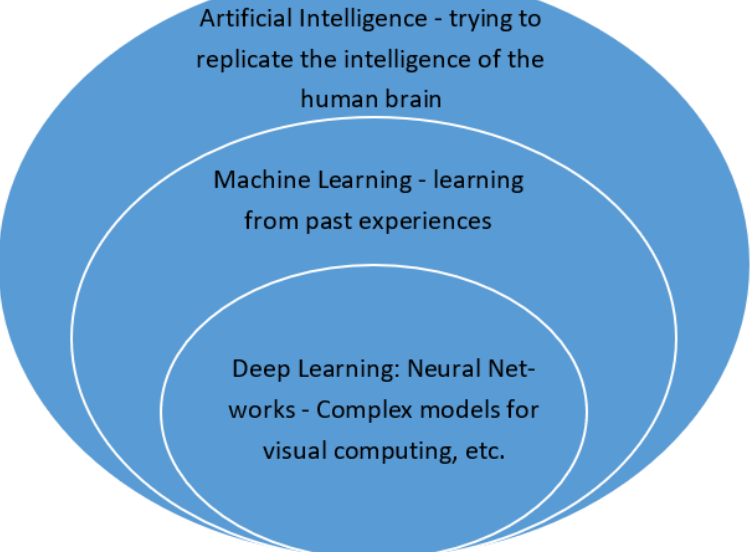
Figure 1. Artificial Intelligence and Machine Learning Hierarchy .